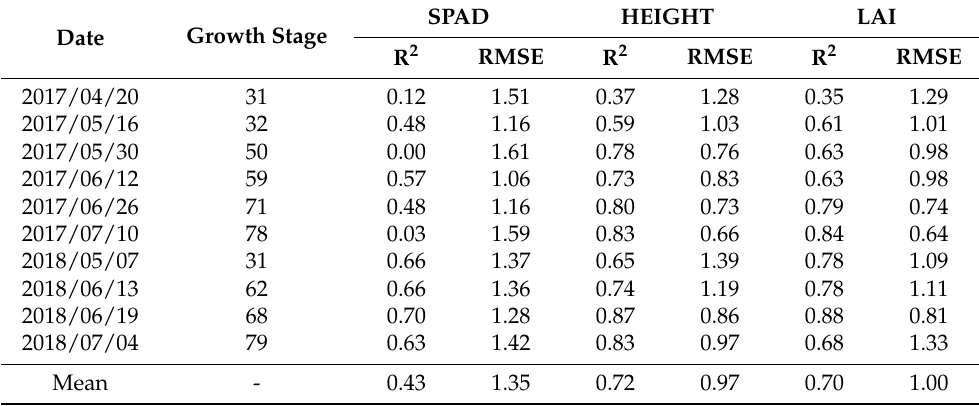
Table 1. Coefficients of determination (R 2 ) and root-mean-square-error of calibration (RMSE) for linear model correlations between yield and individual canopy variables (leaf chlorophyll content Figure 2. and RMSE for each canopy property across all